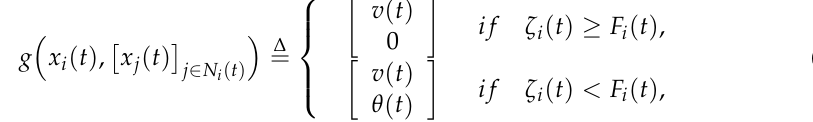
Figure 8. Flowchart of BCCS for coverage.